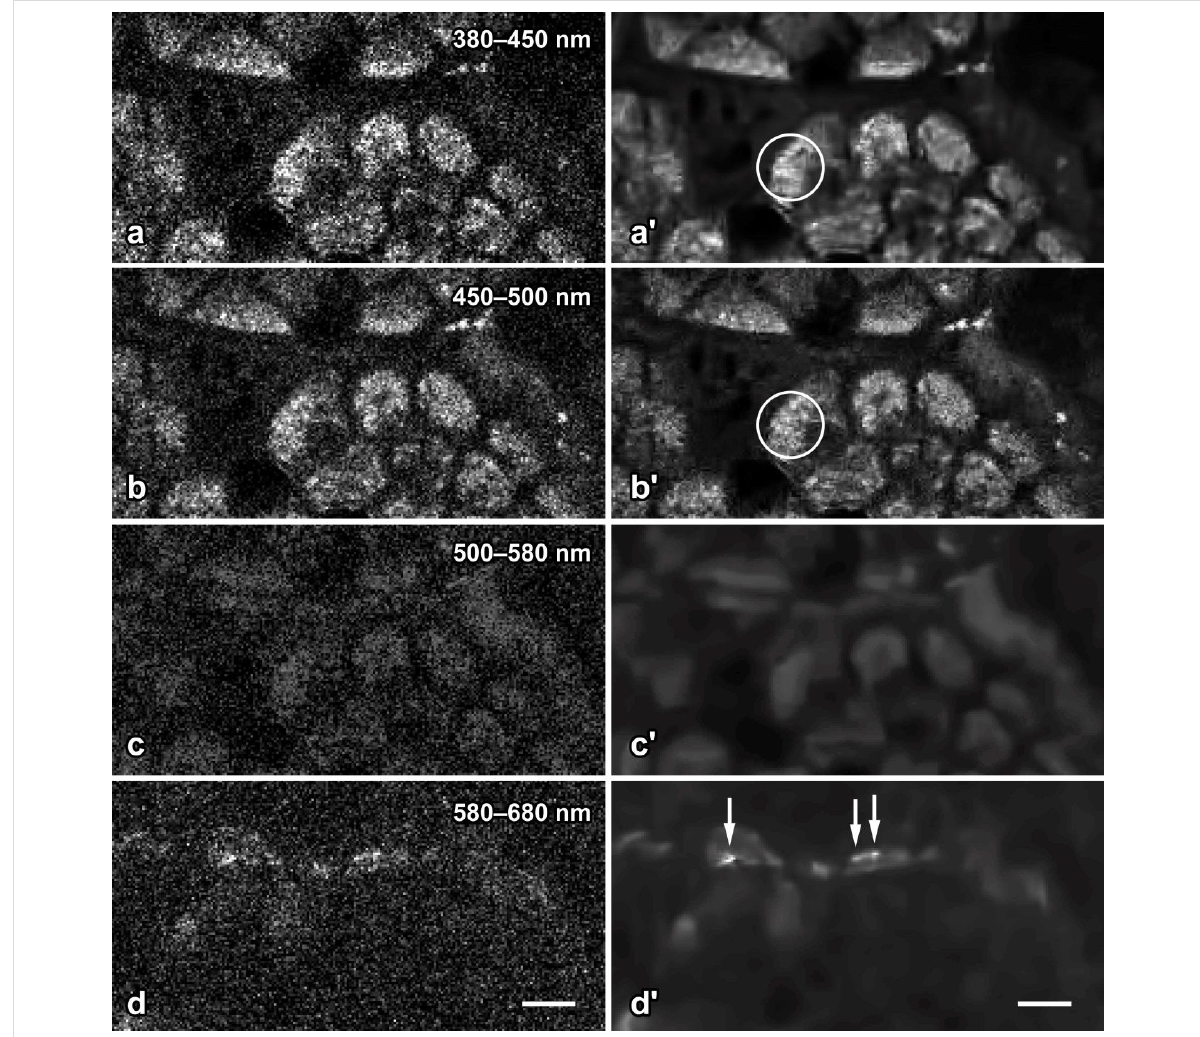
Figure 7: Epithelial cells and quantum dot nanoparticles of the murine gut mucosa in intravital 2-photon microscopy. The eight images correspond to the same field of view; raw data are shown in the left column (a–d), and the corresponding denoised images in the right (a ′ –d ′ ). Nonlinear excitation of tissue and nanoparticle fluorescence was carried out 730 nm. The emitted light was split to four spectral channels, separated by dicroic mirrors at 450, 500 and 580 nm. The modified BM3D algorithm successfully reduces shot noise, but preserves fine structural details in the apical cytoplasm of the cells (encircled in a ′ and b ′ ). Quantum dot nanoparticles (arrows in d ′ ) adhere to the apical surface of the cells and emit in channel 4 only. Denoising by the modified BM3D algorithm considerably facilitates the perception of the nanoparticles by the human observer (compare d to d ′ ) and allows for automated image analysis to be applied to denoised 2PM images. Bar = 5